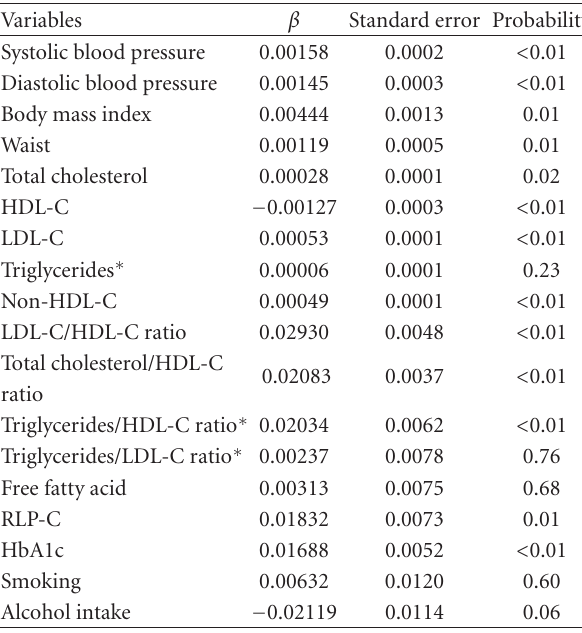
Table 2: Association between IMT and variables at baseline in multiple linear regression analysis adjusted for age and sex.